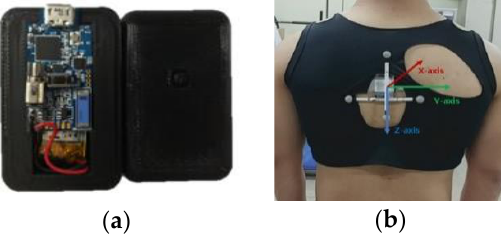
Figure 1. ( a ) IMU and ( b ) sensor position.